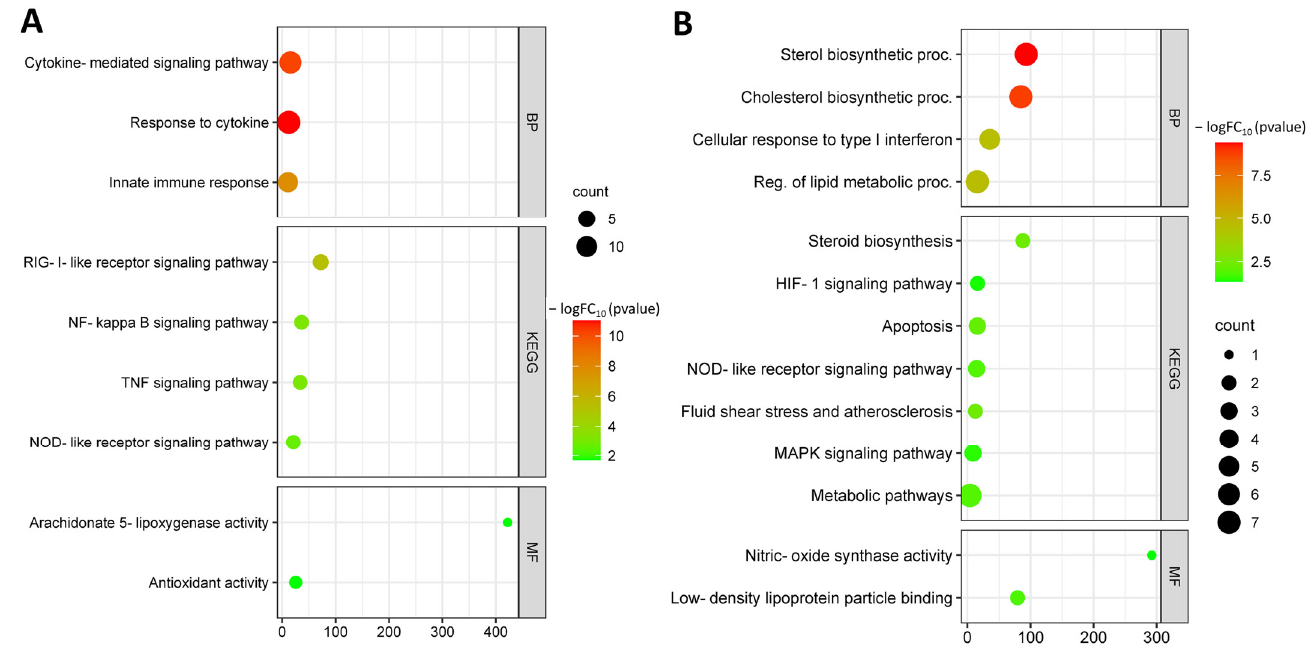
Figure 13. Functional enrichment of common up-regulated hub DEGs ( A ); functional enrichment of common down-regulated hub DEGs ( B ).